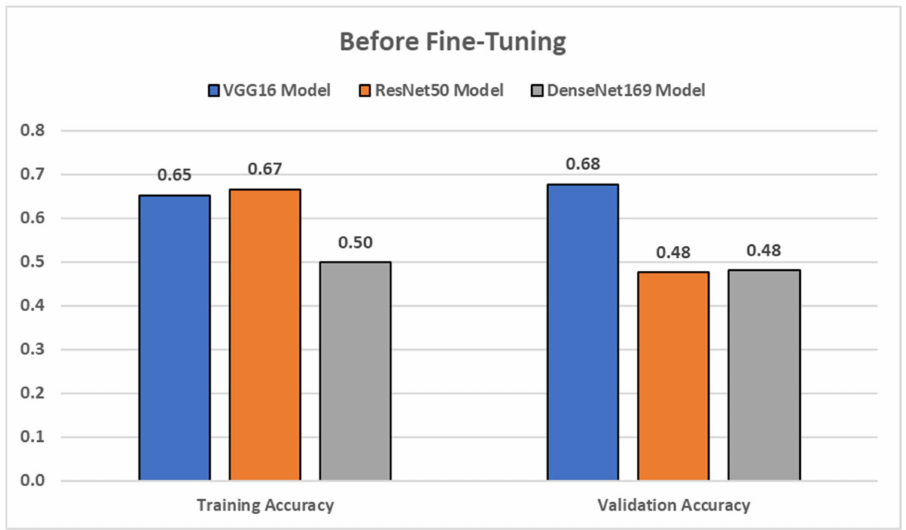
Figure 8. Overall training and validation accuracy before fine-tuning for the original APTOS dataset (after 2